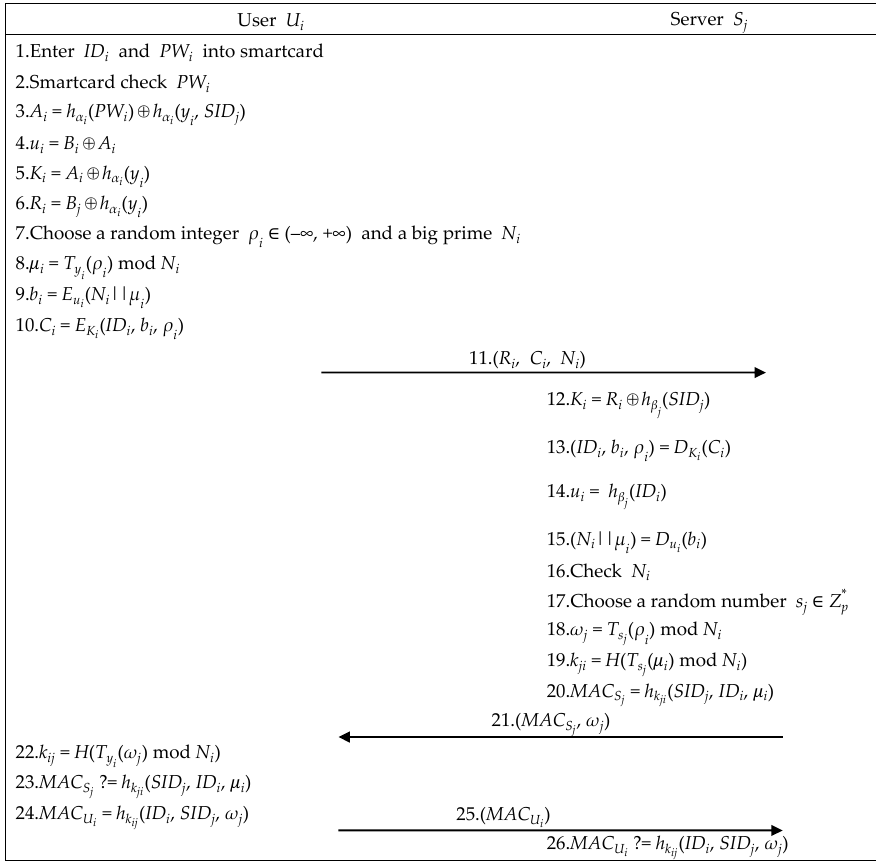
Figure 5. Offline password change phase of the proposed scheme. Step 1.